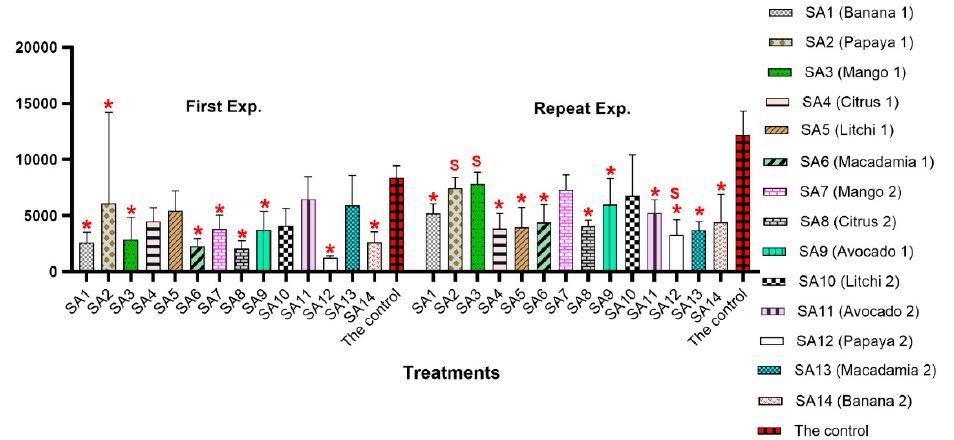
Figure 1. Population densities of Meloidogyne enterolobii in roots of tomato (Moneymaker) 7 weeks post-inoculation with 2000 eggs and second-stage juveniles and 9 weeks post-inoculation with microbial communities associated with the rhizosphere of various tropical fruit trees. Red asterisks indicate significant differences at p ≤ 0.05 based on Tukey’s test for each treatment compared to the control in respective experiment. Letter “S” indicates a significant difference p ≤ 0.05 compared to the same treatment in the first